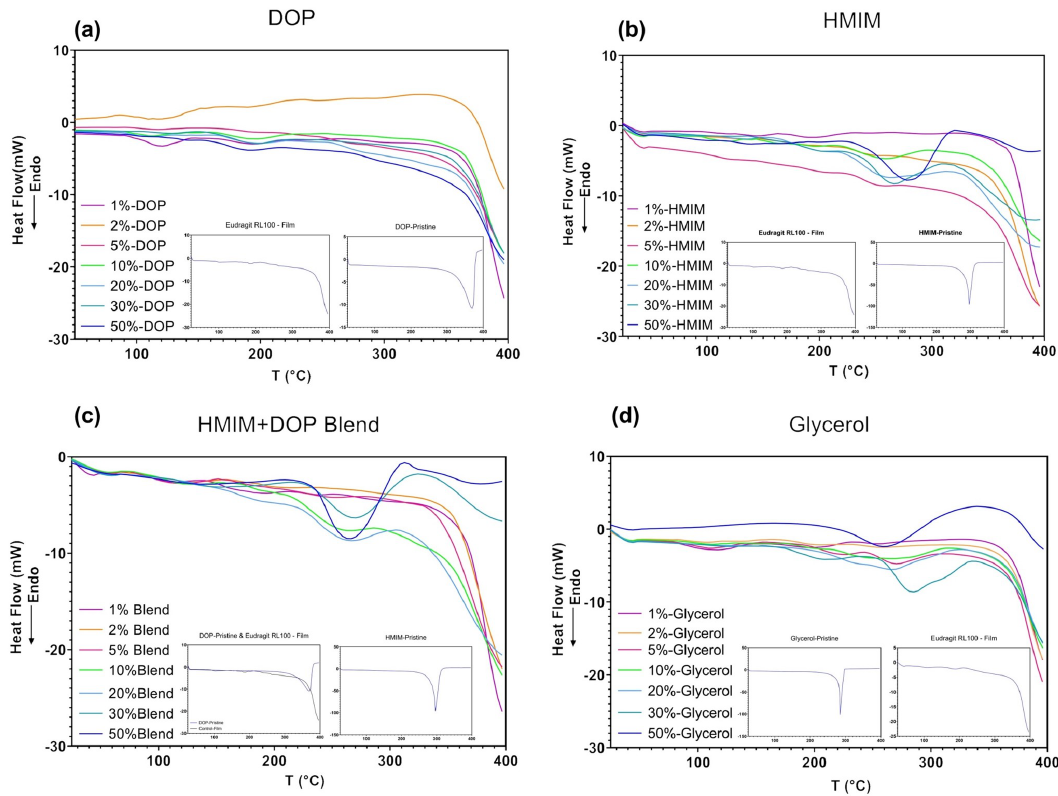
Figure 4. DSC thermogram of ( a ) DOP, ( b ) HMIM and ( c ) HMIM and DOP blend ( d ) Glycerol plasticized samples. (insert contain reference